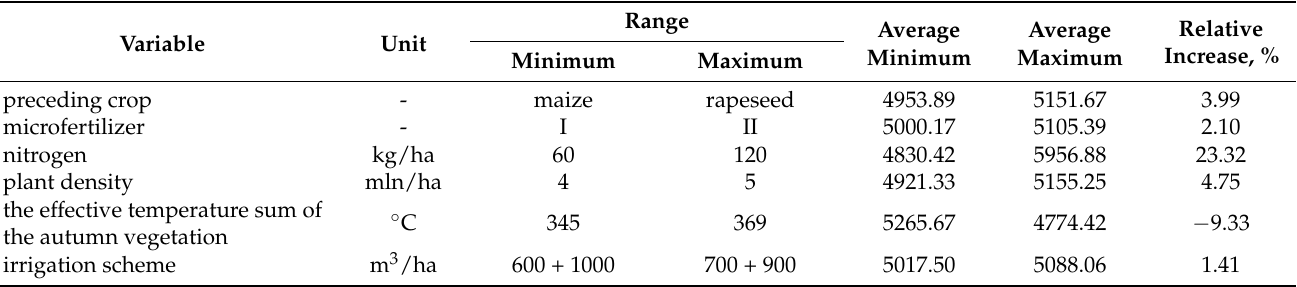
Table 2. The weight of each